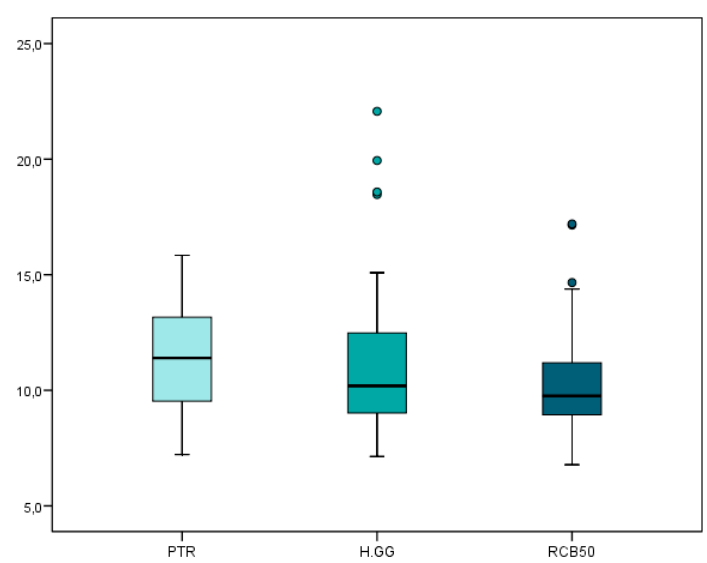
Figure 3. Box plot of the carrier-based root canal filling material removed volume (mm 3 ) regarding the non-surgical endodontic retreatment techniques. PTR: ProTaper Retreatment endodontic rotary instruments; RCB50: Reciproc Blue endodontic reciprocating instrument; H-GG: combined root canal retreatment technique between Gates-Glidden drills and Hedstrom files.